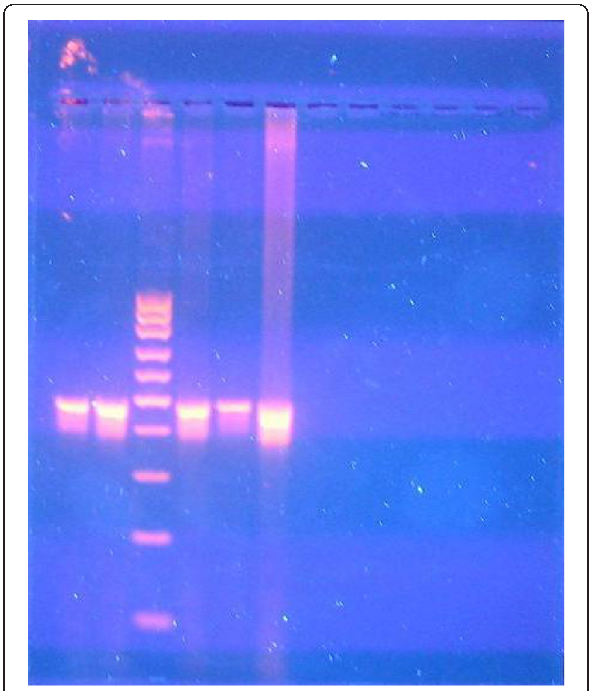
Figure 7 M. leprae , positive polymerase chain reaction DNA analysis.